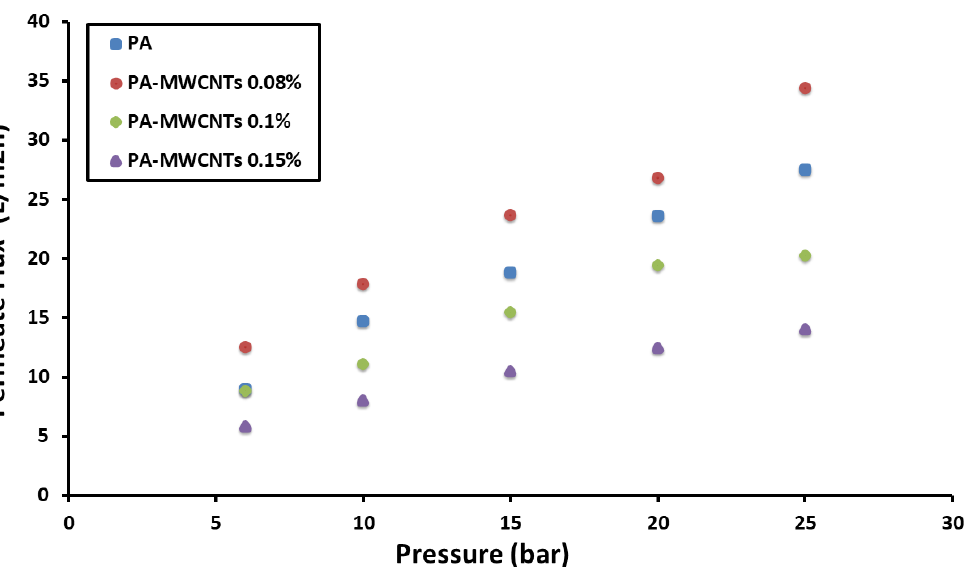
Figure 11. Flux rates plotted against transmembrane pressure of PA and PA-MWCNTs (0.08%, 0.1%, and 0.15%).